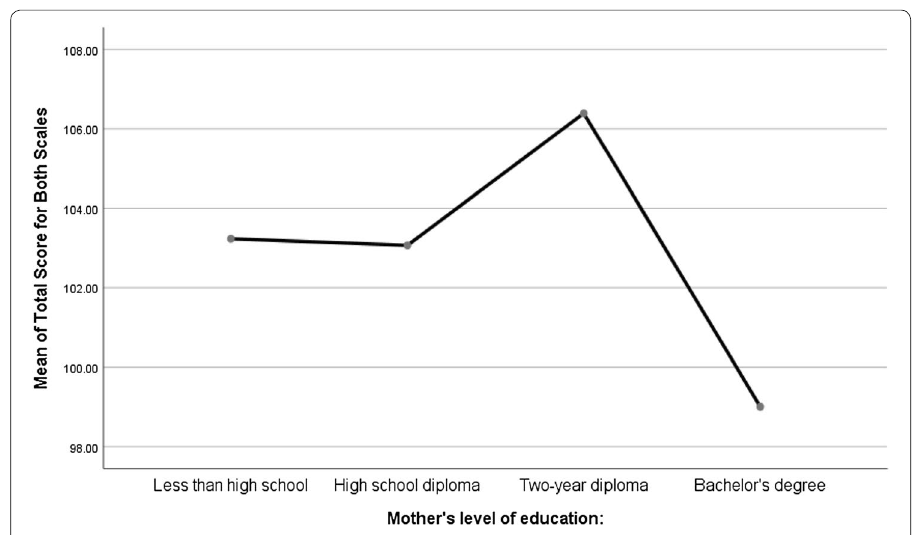
Fig. 1 Mean values for total questionnaire scores based on mother’s level of